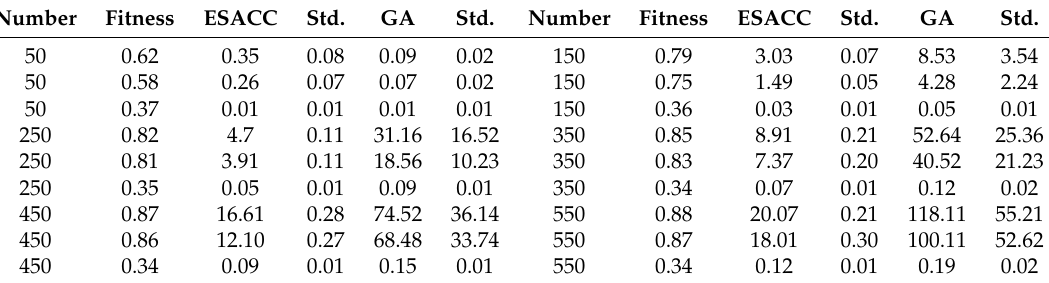
Table 1. The statistic results of experiments. Each experiment was repeated 30 times to compare the average computation time (seconds) between ESACC and GA at different fitness values. Fitness ESACC Std. GA Std. Fitness